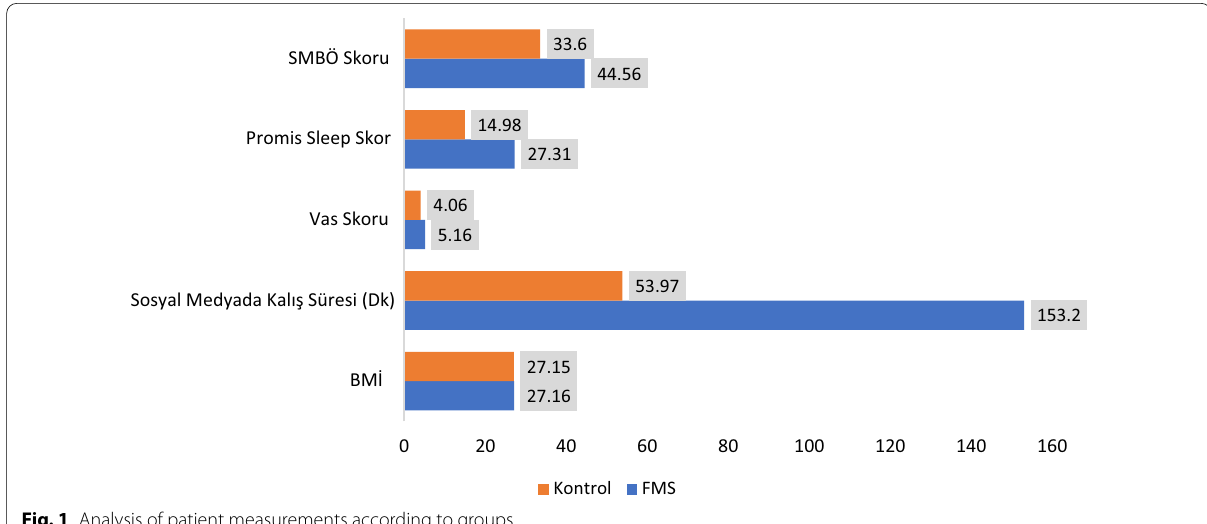
Fig. 1 Analysis of patient measurements according to groups